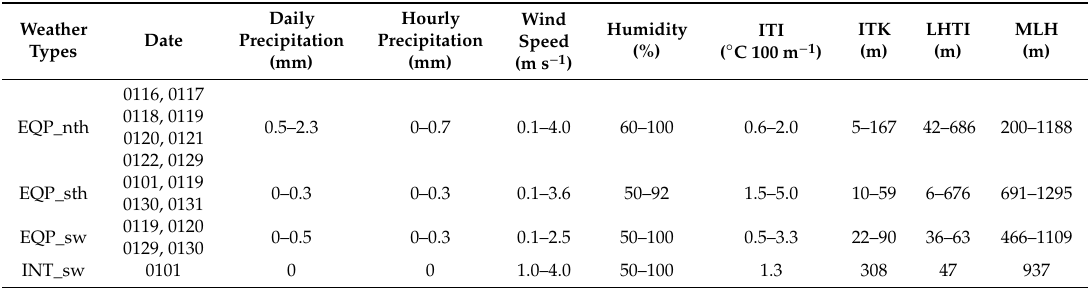
Table 2. Dates of RPHPDs (regional PM 2.5 pollution days) and variation range of eight meteorological elements in Jiangsu in the winter of 2018. (equalized pressure (EQP), advancing edge of a cold front (ACF) and inverted trough of low pressure (INT).EQP in North Jiangsu (EQP_nth), EQP in South Jiangsu (EQP_sth), EQP in Southwest Jiangsu (EQP_sw), EQP in Coastal Jiangsu (EQP_cst), ACF